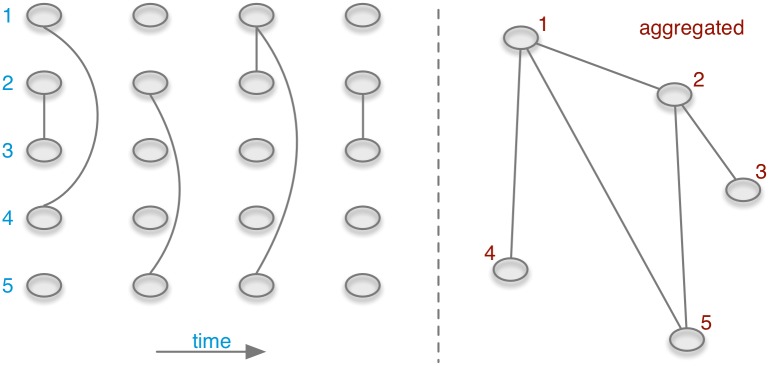
A temporal network (left) and its static counterpart (right).